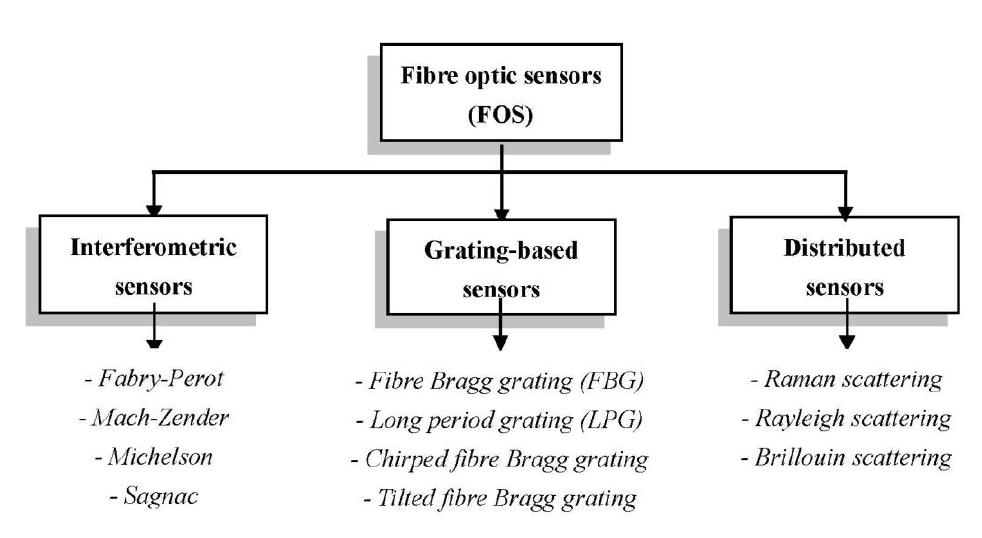
Figure 2. Overview of basic principles and types of fibre optic